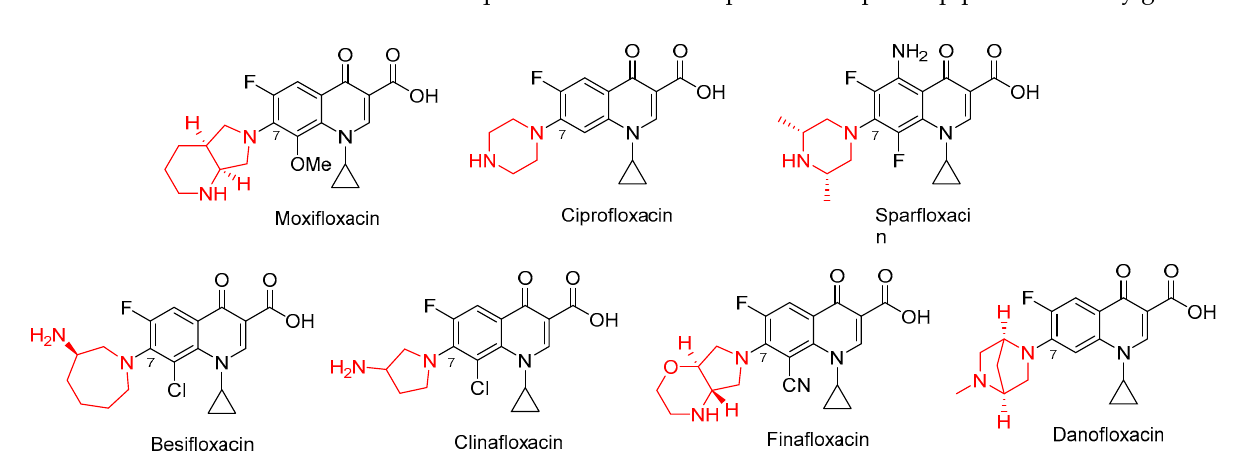
Figure 1. Approved and advanced investigational fluoroquinolones with variable 7-amino group.